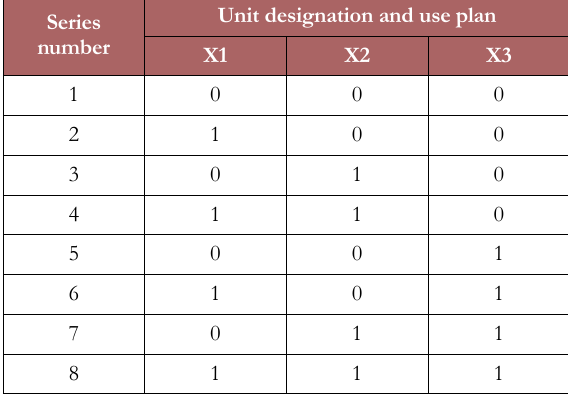
Table 1. Lexicographic sequence for three